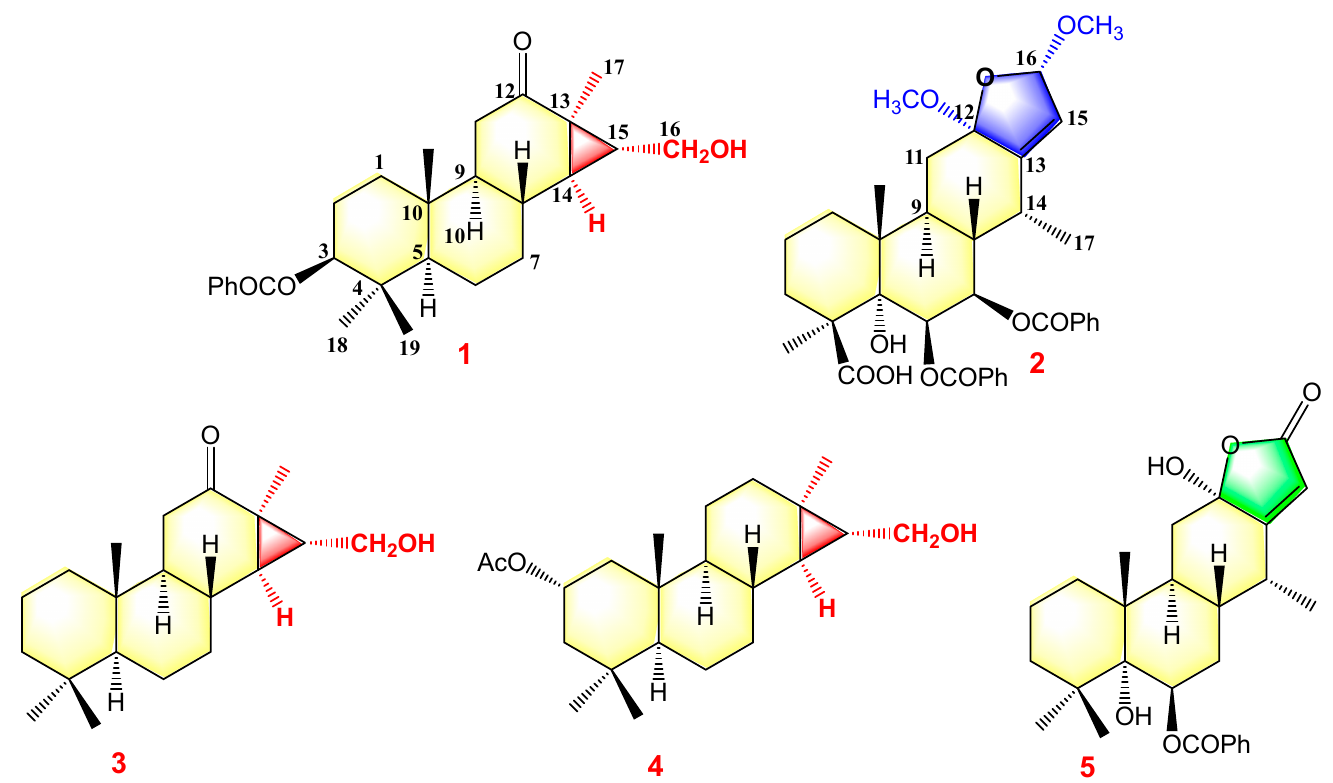
Figure 3. Structures of compounds 1 – 5 Pulchin B ( 2 ) was obtained in the form of a white amorphous powder with the molec- ular formula C 36 H 42 O 10 , as determined by a combination of HREISMS (measured: m/ z 657.2670 [M+Na] + , calculated: 657.2670) and NMR spectra, including 1 H, 13 C, and DEPT. The